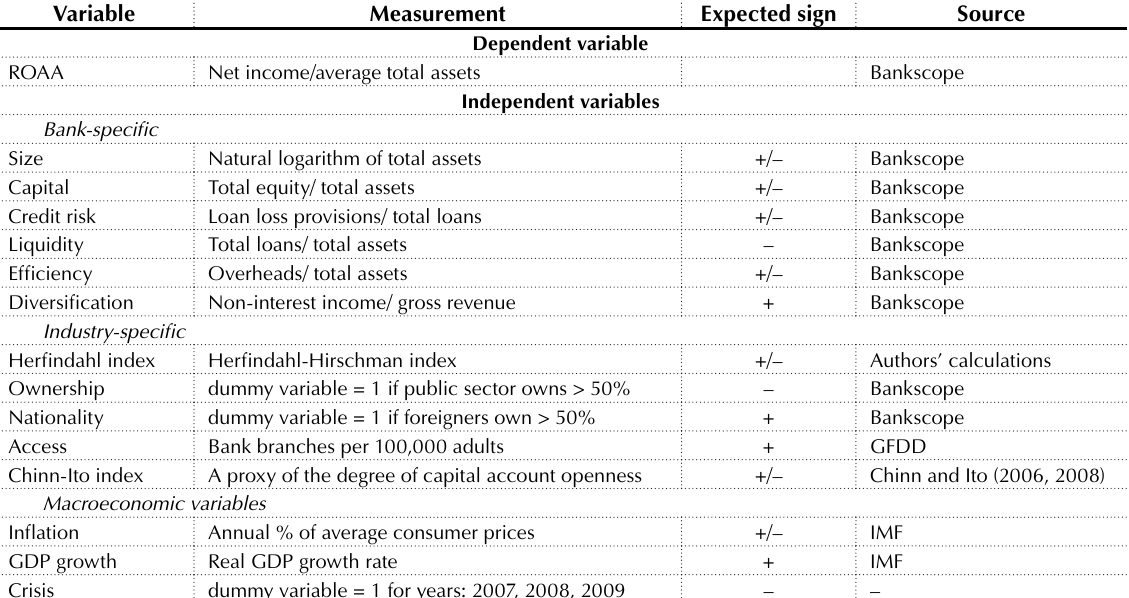
Table 1. Summary of the variable